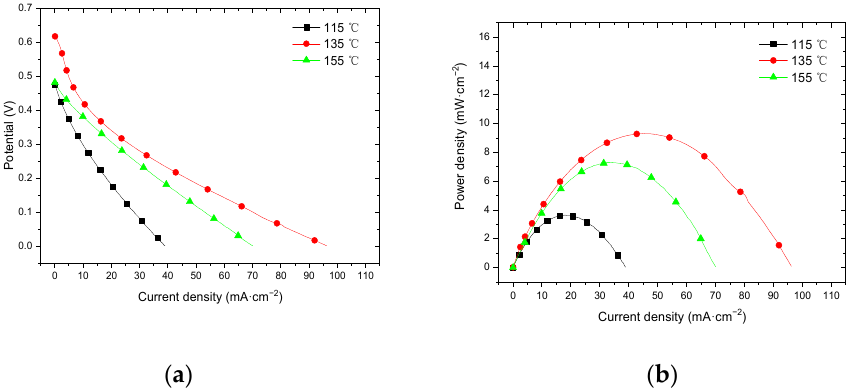
Figure 15. The effect of hot-pressing temperature on the performance of titanium mesh-based MEA